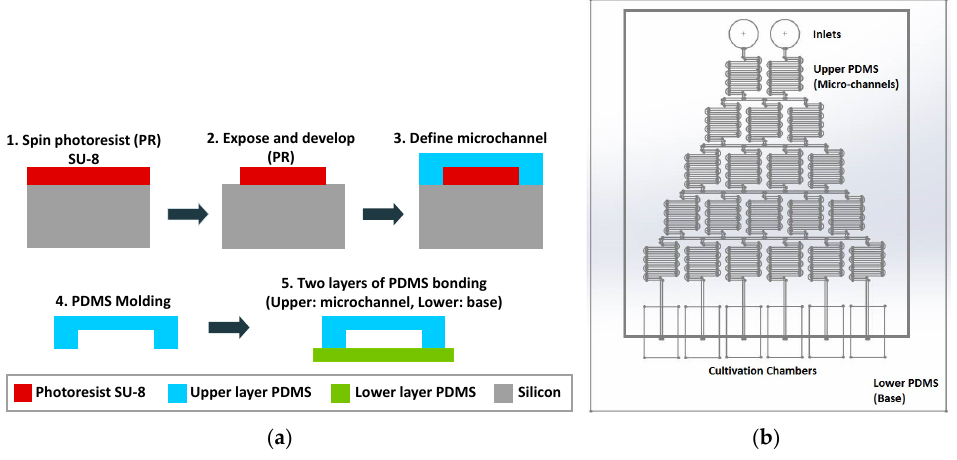
Figure 1. ( a ) Microfabrication process for the concentration gradient generator system. ( b ) Microfluidic chip composed of two layers of PDMS with six cultivation chambers.